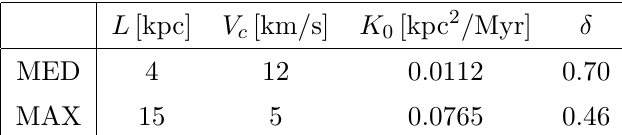
Table 2. Galactic transport model parameters for the MED and MAX